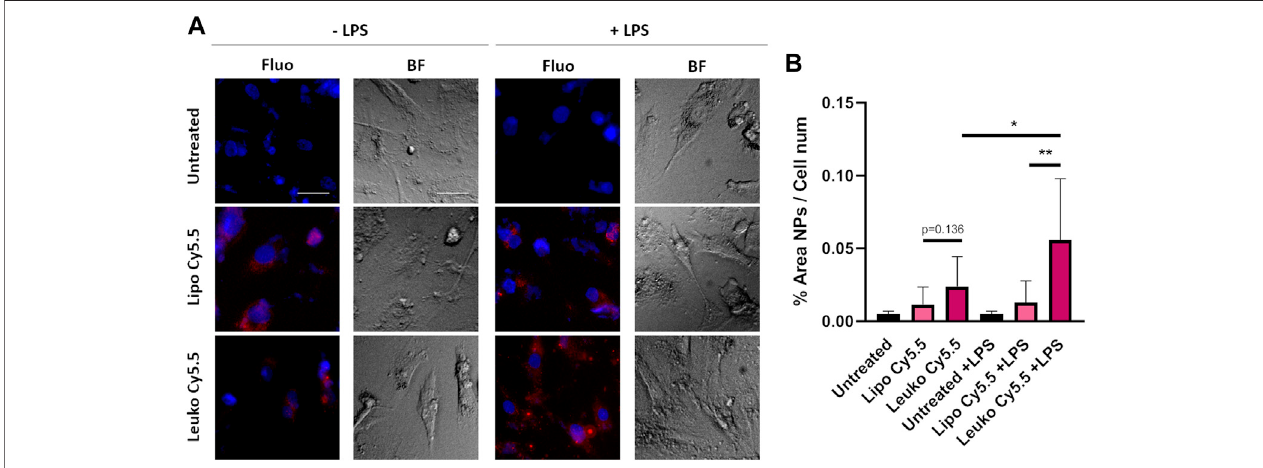
FIGURE 6 | (A) Fluorescence (Fluo) and respective bright fi eld (BF) images of HUVEC cells cultured onto gelatin-coated plates and treated with either Lipo Cy5.5 or Leuko Cy5.5 in the presence of 100 ng/ml of LPS or not, for 3 h. (B) Quanti fi cation of Lipo and Leuko fl uorescence at different time points during uptake. ( p p ˂ 0.05; pp p ˂ 0.01, and n = 3 for all the performed